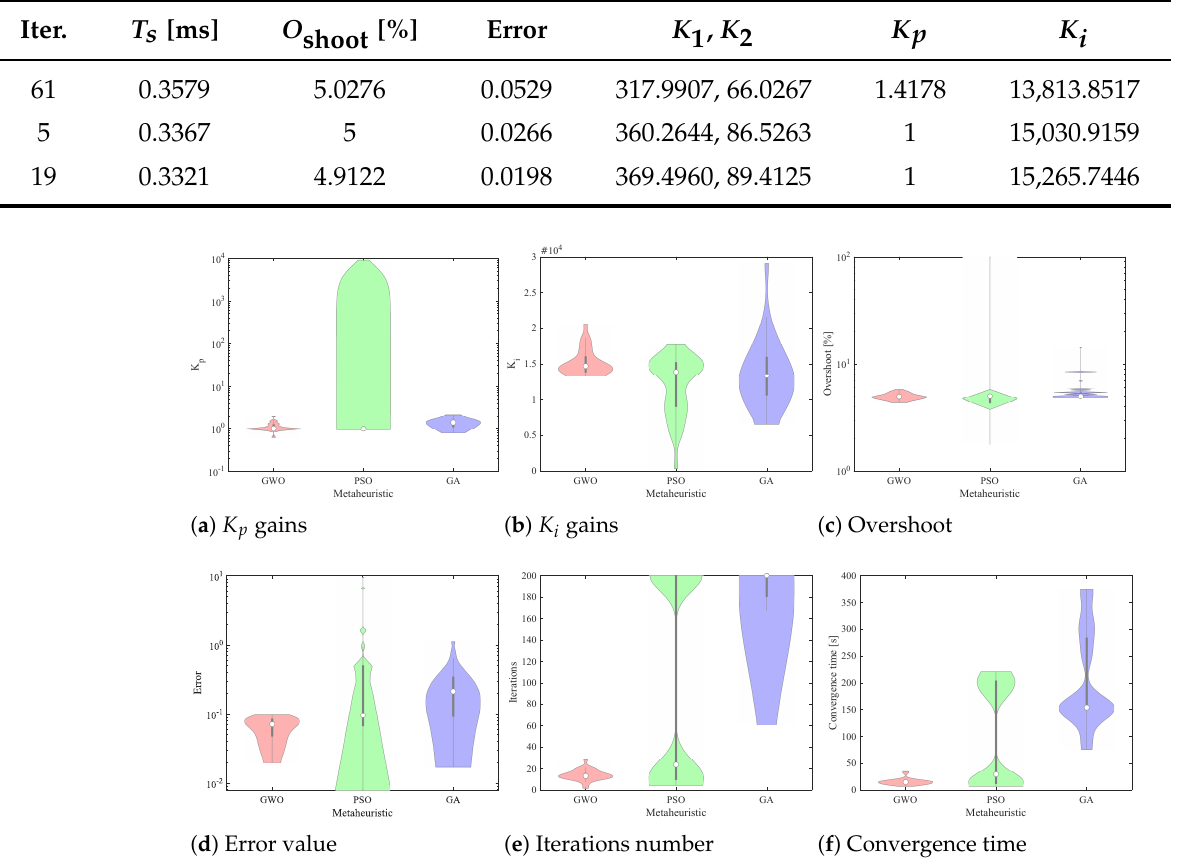
Figure 16. Performance metrics of 30 runs of each metaheuristic for optimizing the controller of the